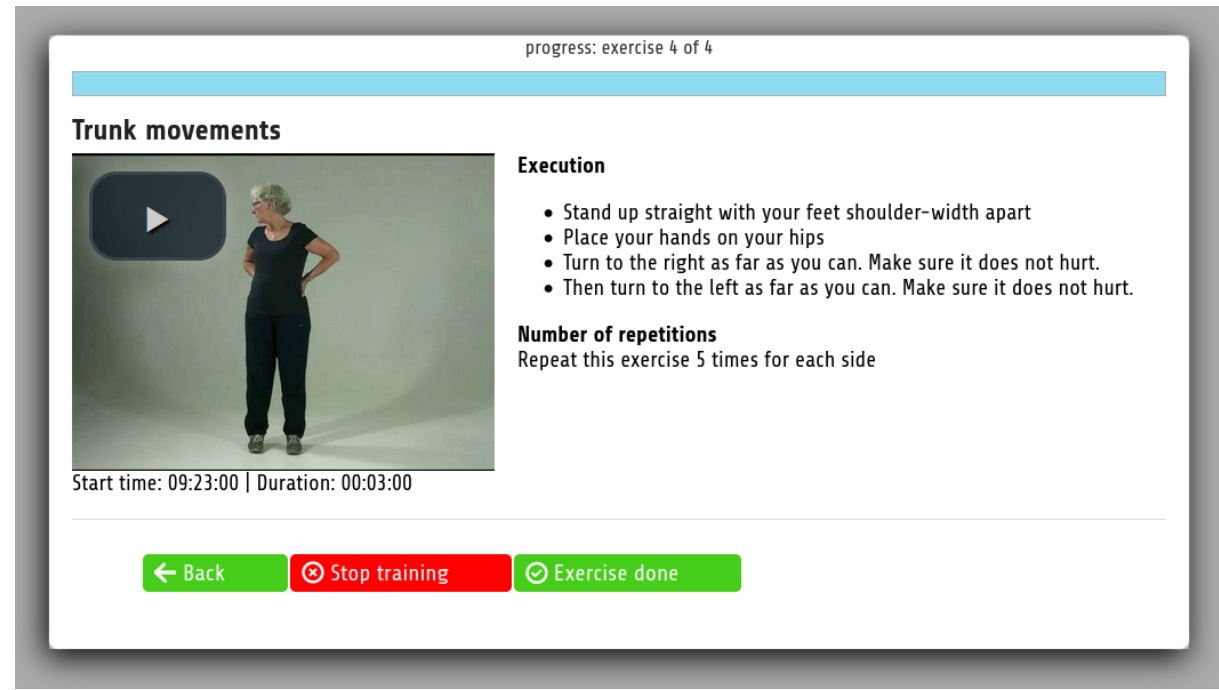
Figure 2. Screenshot of the Otago exercise